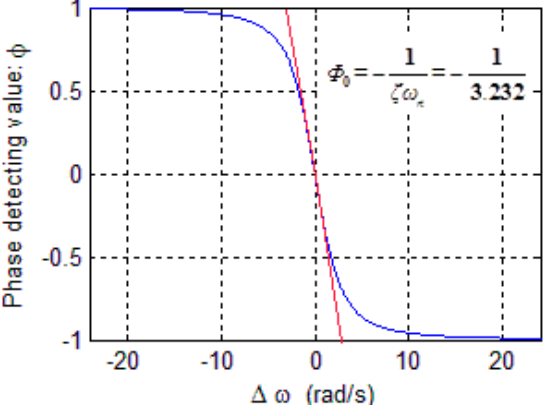
Figure 13. Relationship curve between Φ and Δω .